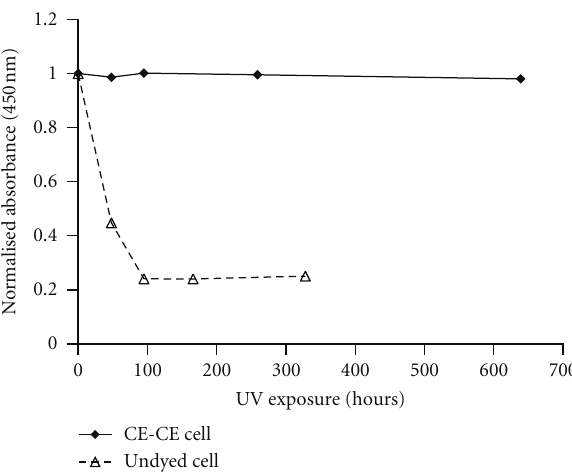
Figure 8: Change in absorbance of model cells. The undyed cell is essentially a complete DSC. The CE-CE cell consists of two counter electrodes and the electrolyte. This clearly shows that TiO 2 is required for electrolyte degradation under UV